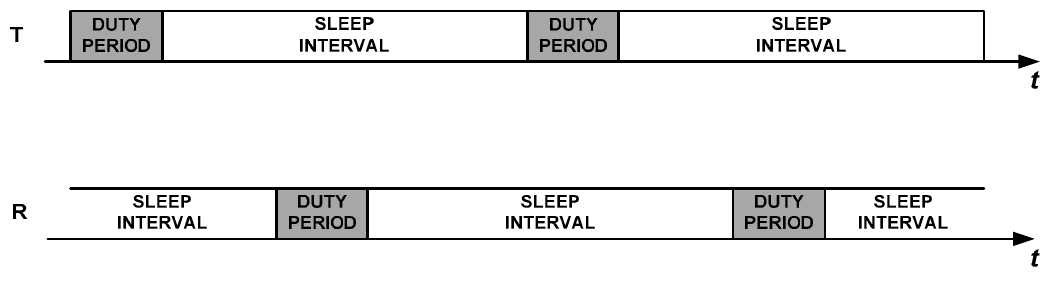
Figure 1. Uncoupled duty cycles between a transmitter node (T) and a receiver node (R) in asynchronous communication.